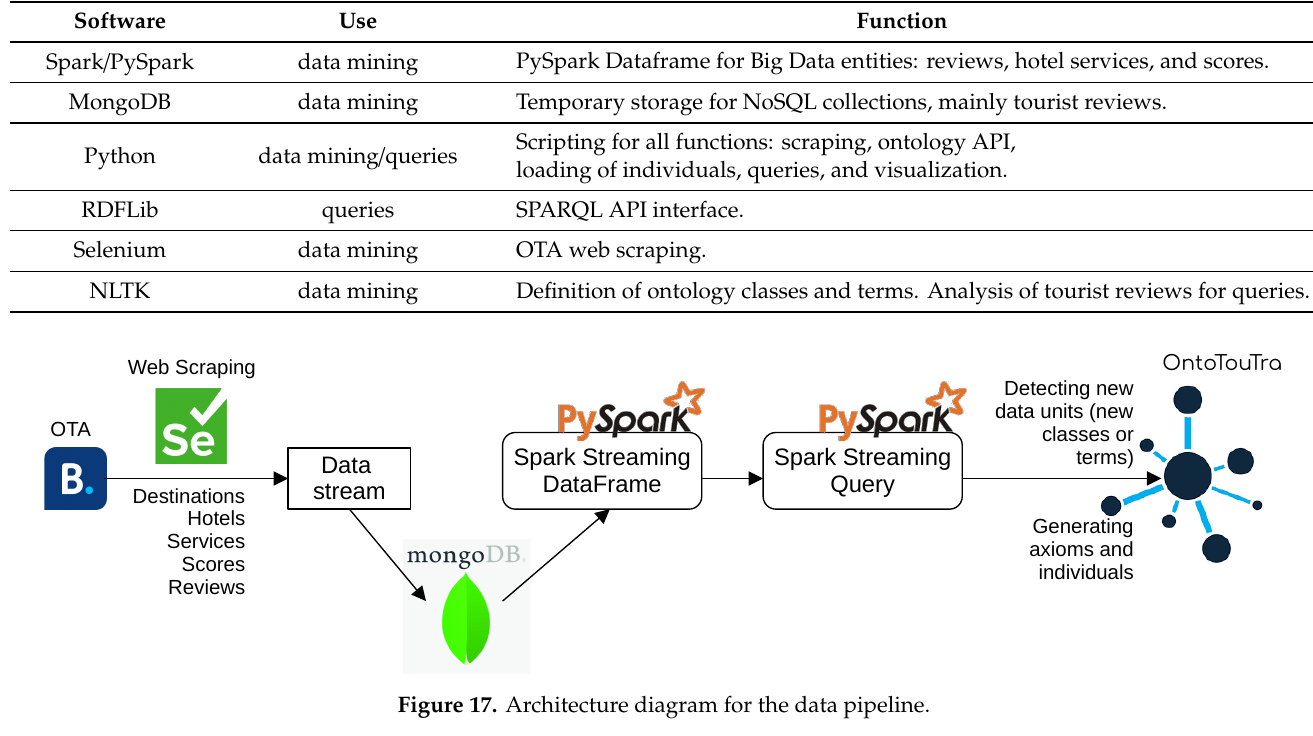
Table 6. Components of the analytics toolkit.